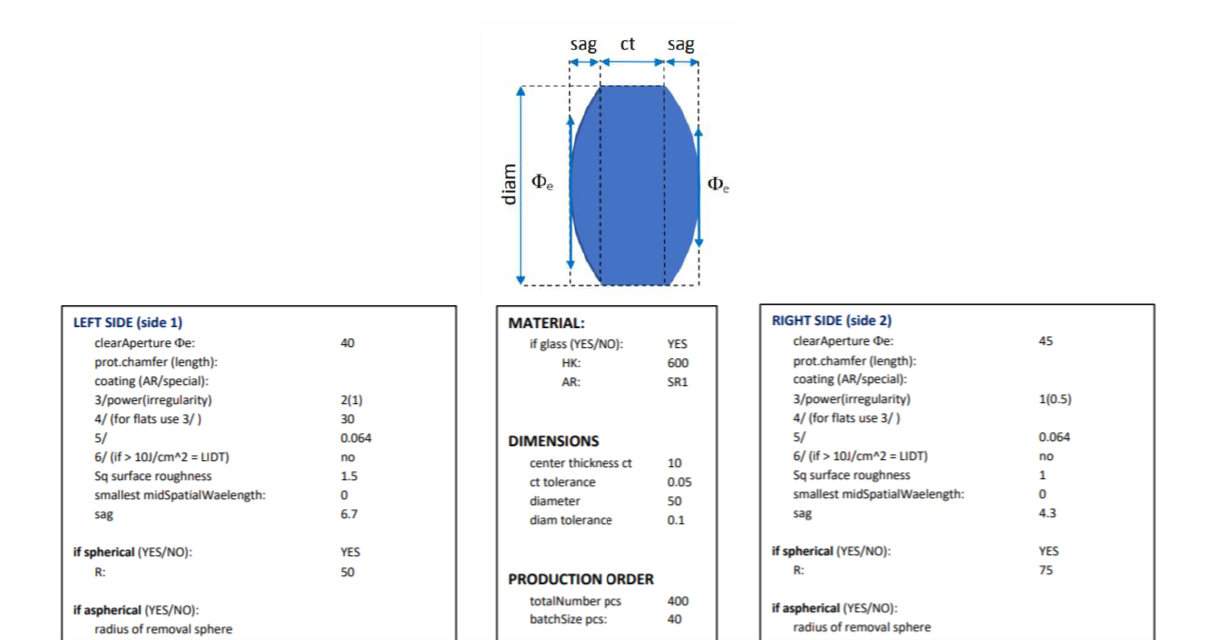
Fig.3. Spherical biconvex lens made of glass.